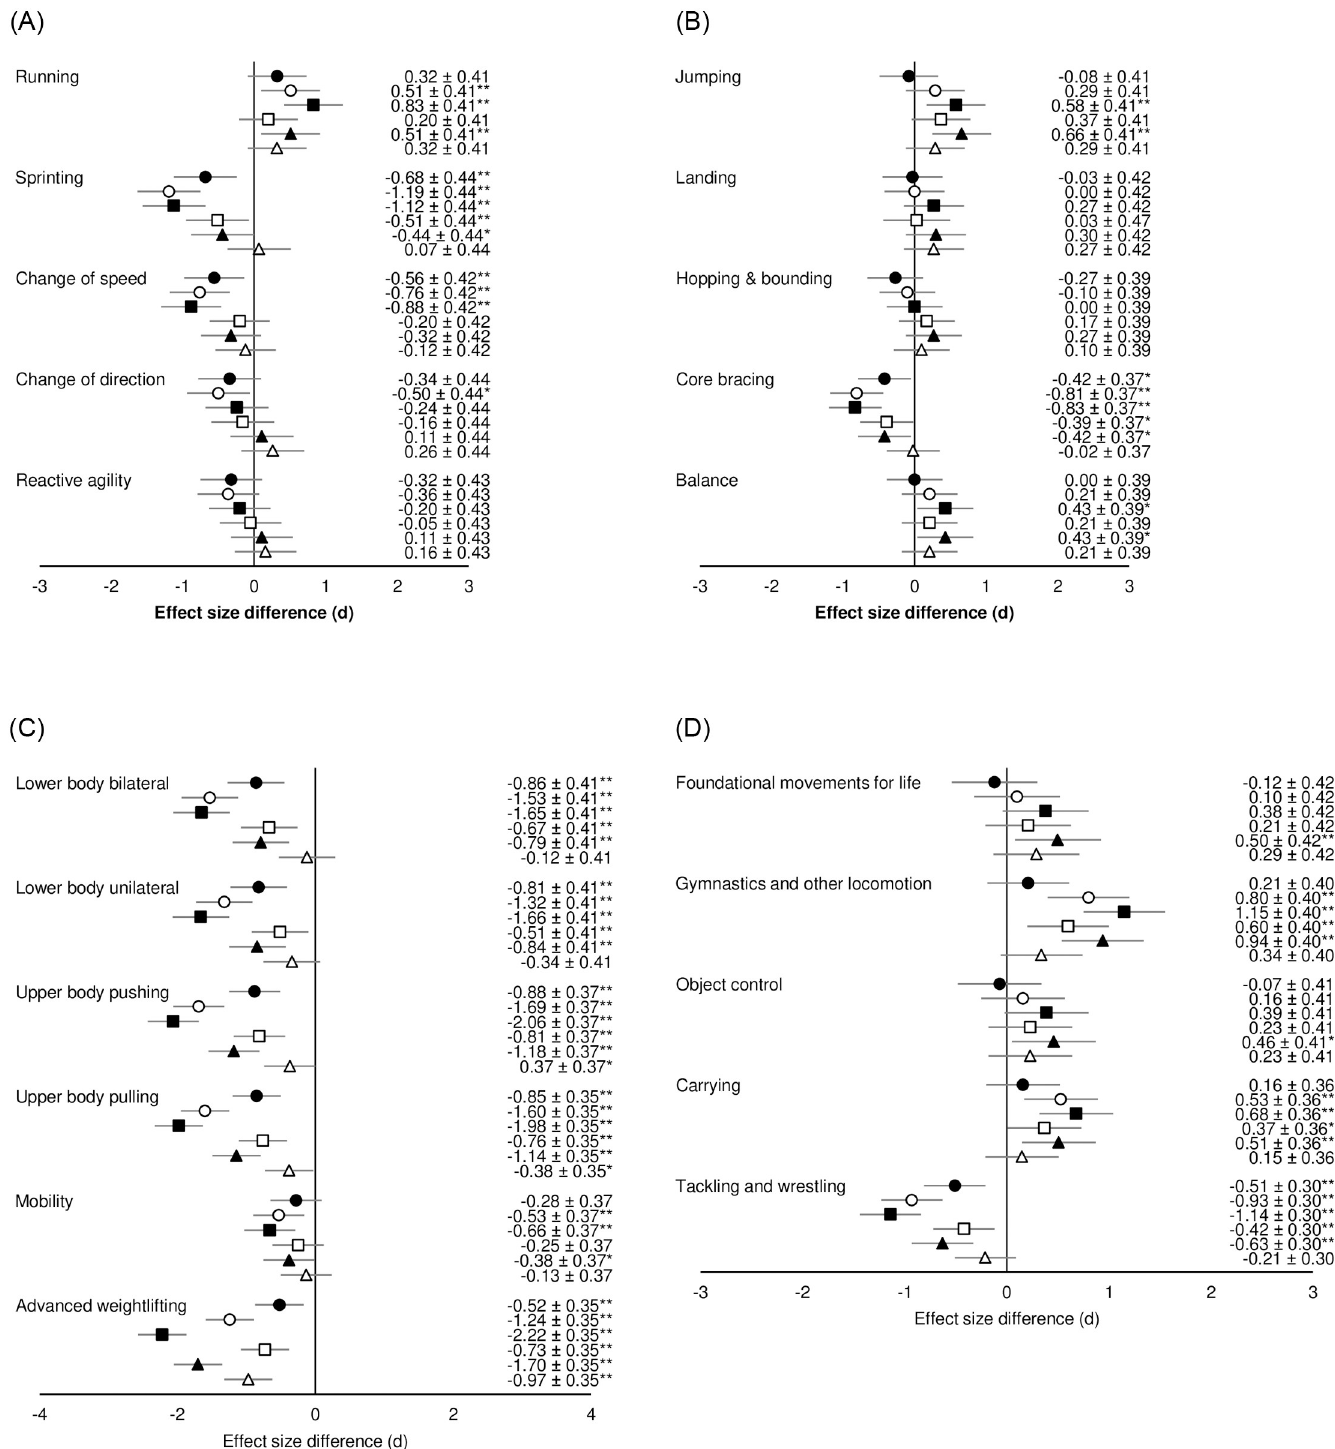
Fig 1. A. Effect size differences in PE teacher’s perceived motor competence importance between stages of maturity for running-based competencies. B. Effect size differences in PE teacher’s perceived motor competence importance between stages of maturity for jumping and stability competencies. C. Effect size differences in PE teacher’s perceived motor competence importance between stages of maturity for strength-based competencies. D. Effect size differences in PE teacher’s perceived motor competence importance between stages of maturity for other fundamental/foundational competencies. Black circles = childhood vs. pre-PHV; white circles = childhood vs. circa-PHV; black squares = childhood vs. post-PHV; white squares = pre- vs. circa-PHV; black triangles = pre- vs. post-PHV; white